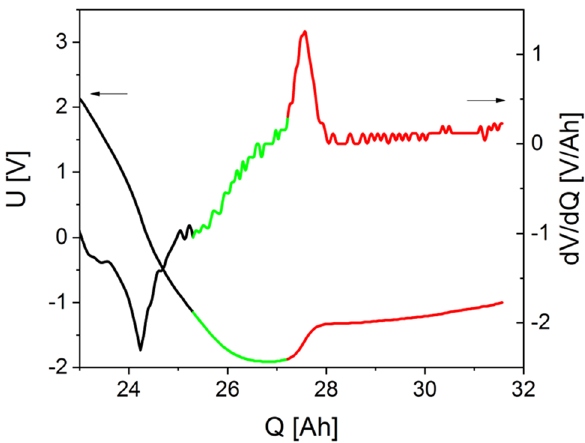
Figure 7. Color coding of the voltage curve and its derivation according to the ongoing